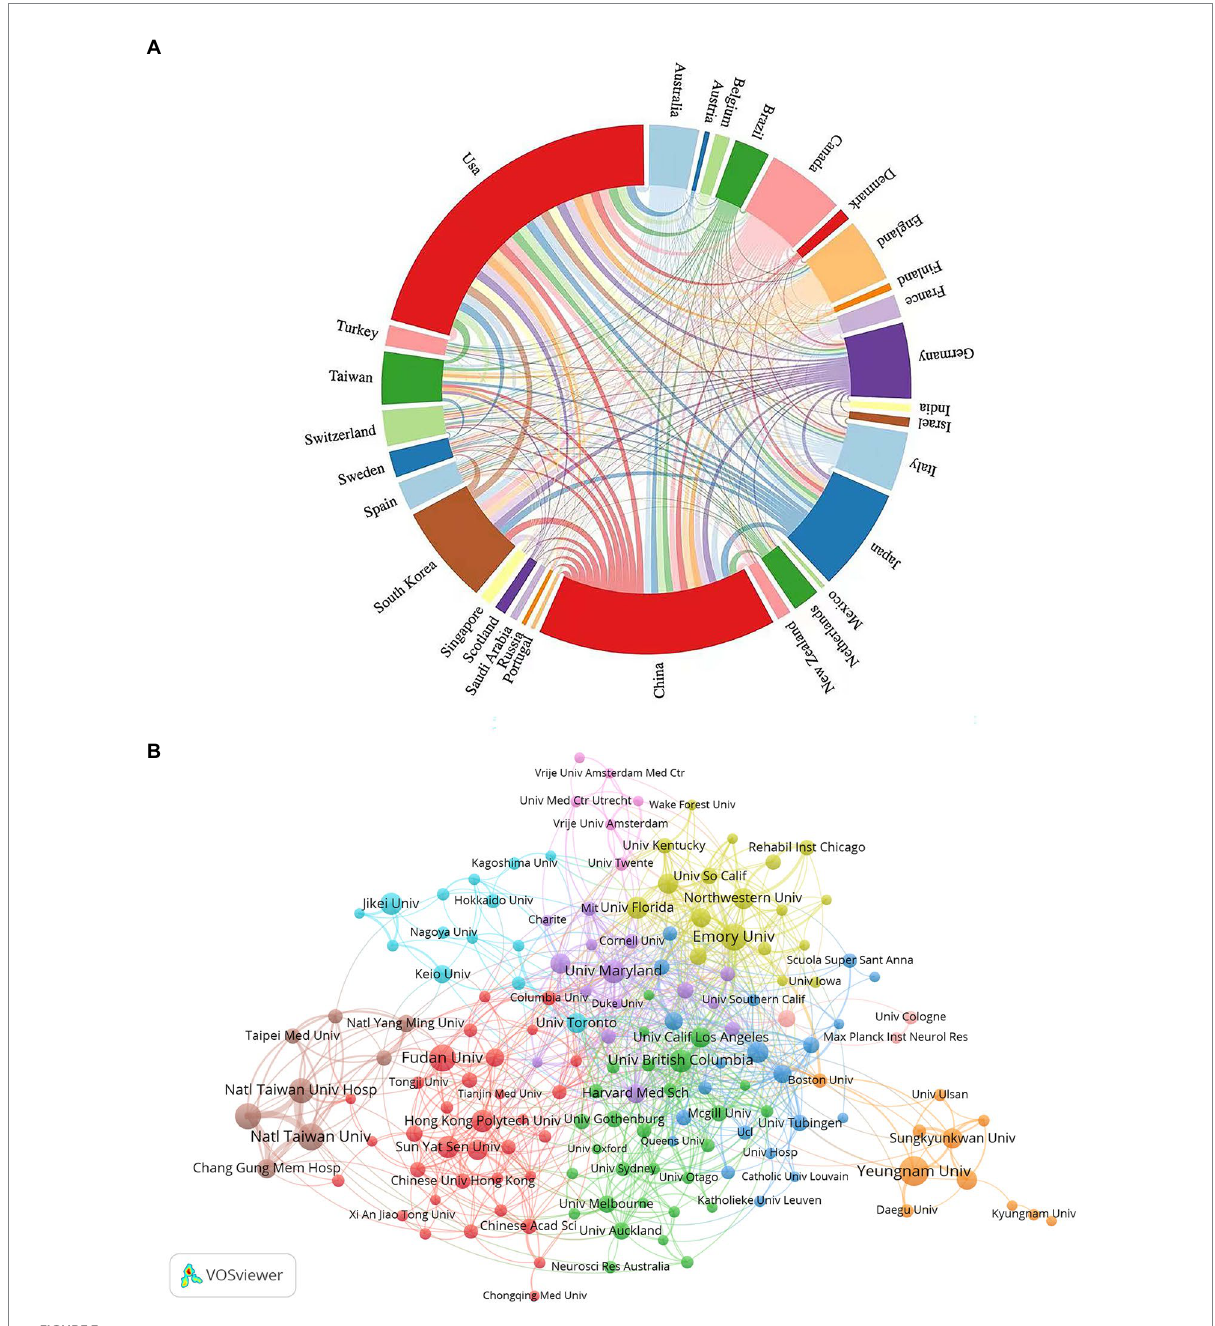
FIGURE 3 (A) countries/regions clustering analysis; (B) institution’s clustering